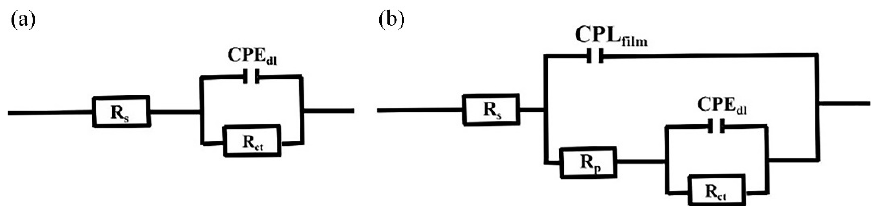
2 , TiO 2 /MoS 2 -K.